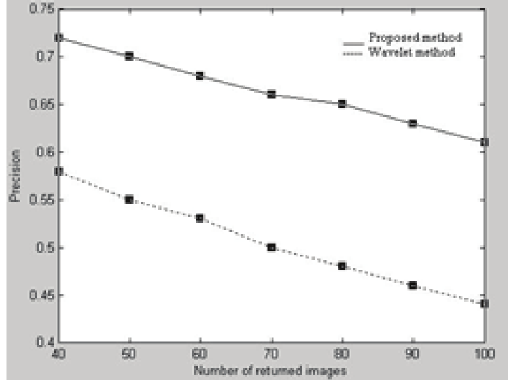
Fig 13: Average precision Vs Number of returned images using proposed method and wavelet method